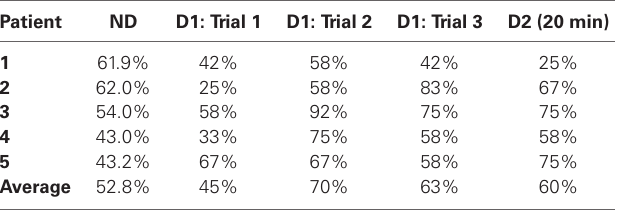
Table 1 | Nondeclarative task (ND) and declarative memory recall test (D1, D2) performance by patient in percentage correct .